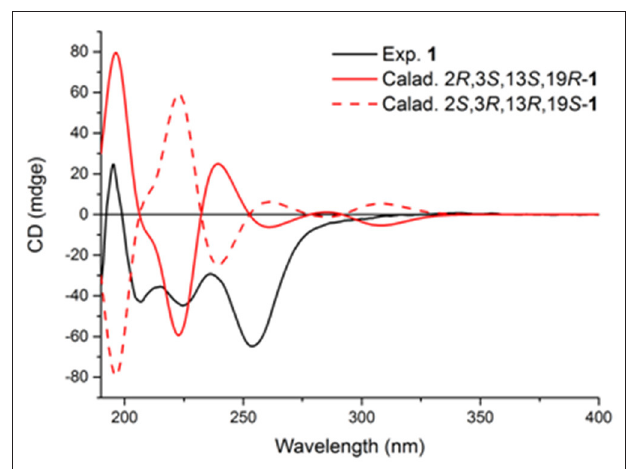
FIGURE 4 | Experimental and calculated ECD spectra of compound 1 .